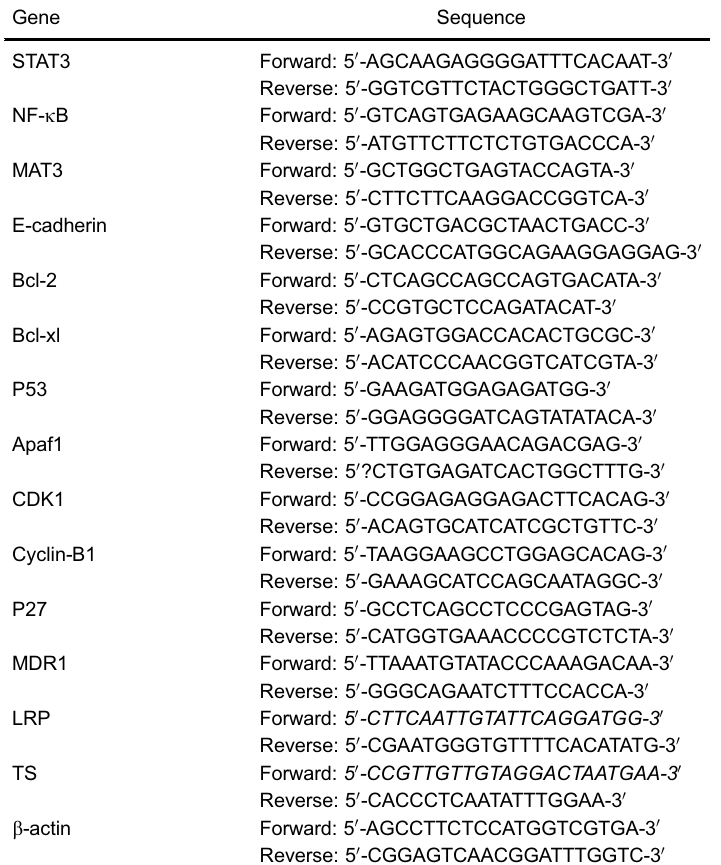
Table 1 . Sequences of primers used in this